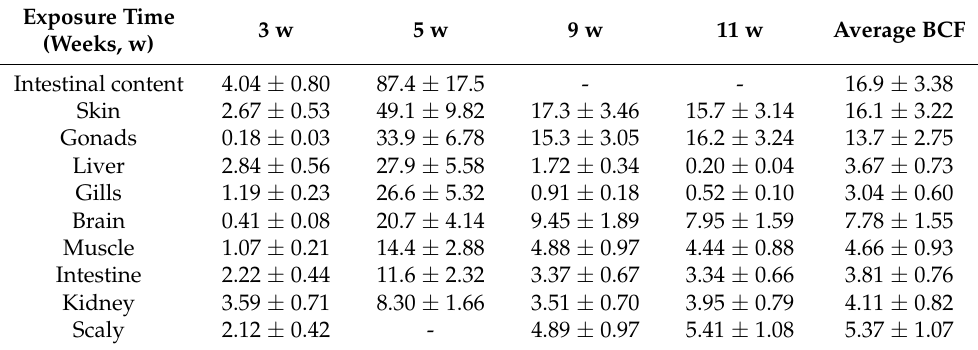
Table 3. BCF values determined in fish